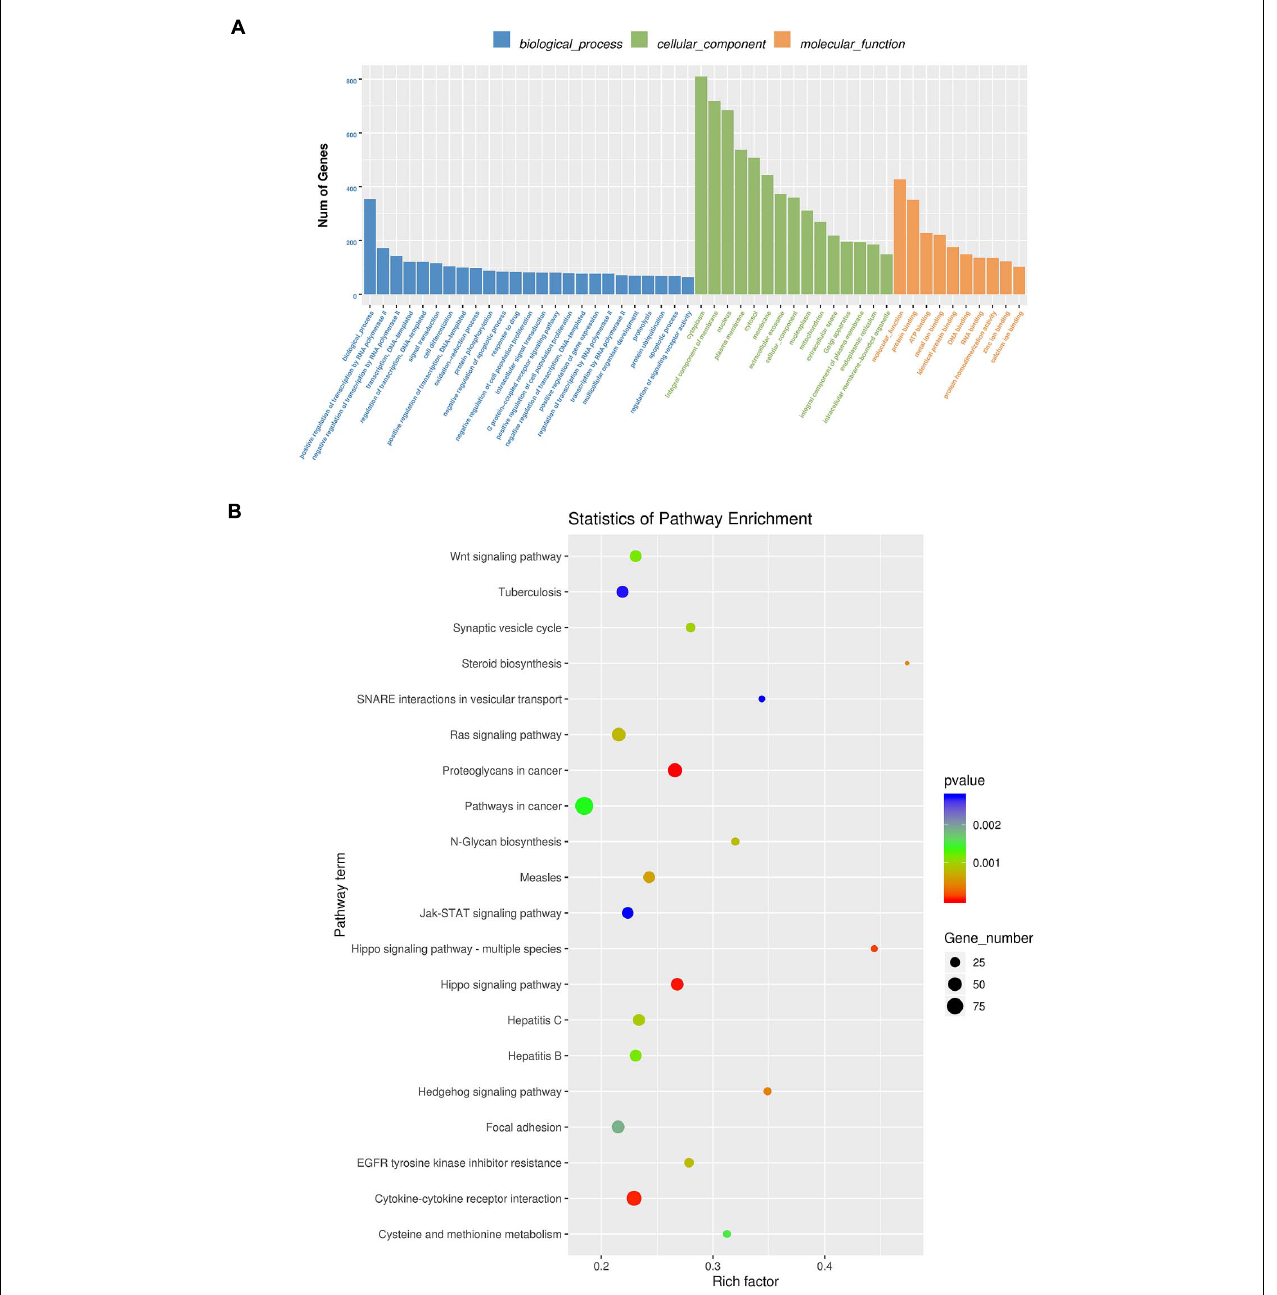
FIGURE 5 | GO analysis and Kyoto Encyclopedia of Genes and Genomes (KEGG) pathway analysis. (A) GO analysis enrichment map of biological process, cell composition and molecular function; (B) KEGG pathway analysis enrichment map (Blue means 0.002 < p < 0.05; Green means 0.002 < p < 0.001; Red means p <